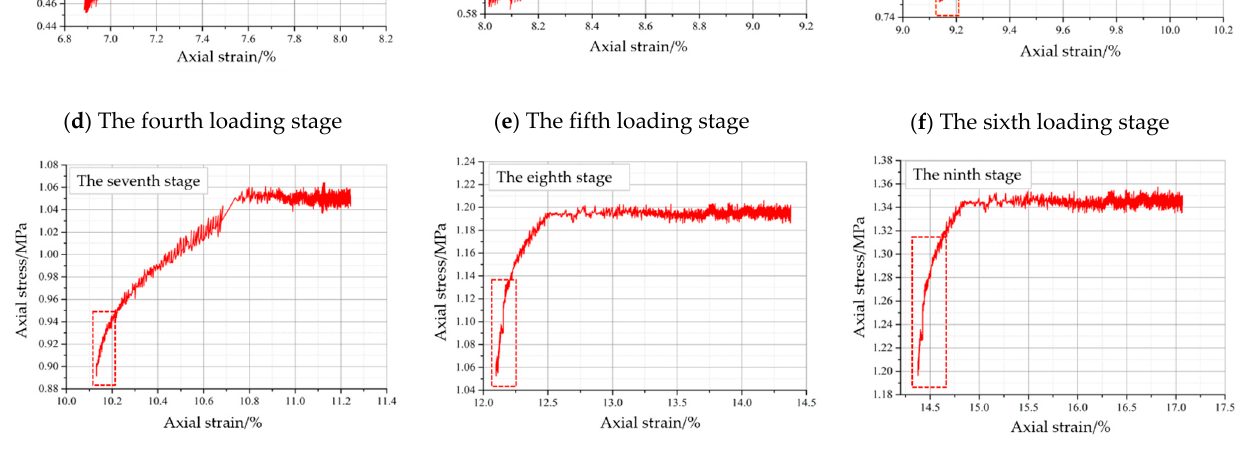
Figure 12. The periodic stress-strain curves of sample S-3 at each loading stage.